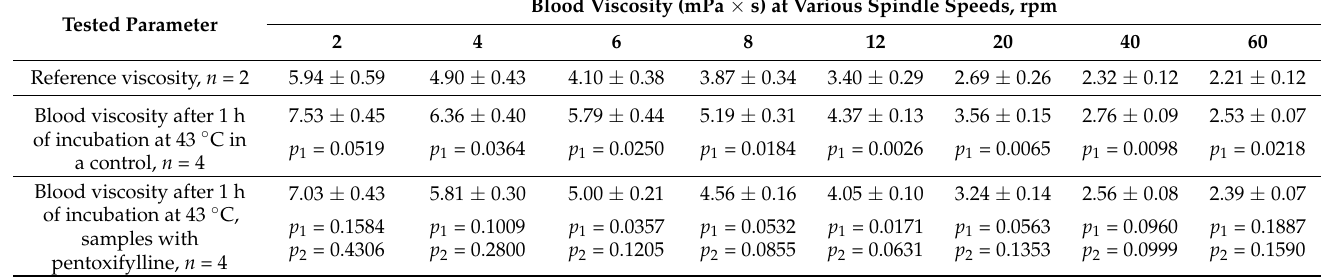
Table 6. Effect of pentoxifiline on blood viscosity (mPa × s) at various spindle speeds in the in vitro blood hyperviscosity model.